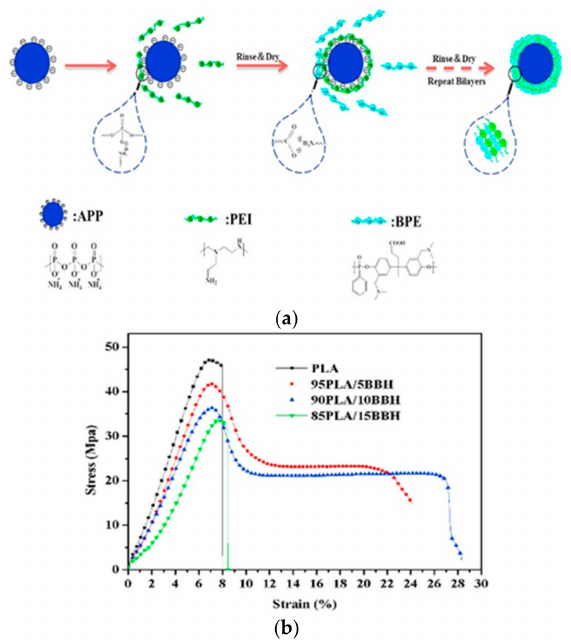
Figure 2. ( a ) Process for layer-by-layer assembly of FR; and ( b ) strain-stress curves of neat PLA and PLA/FR composites (Adapted with permission from [44]).